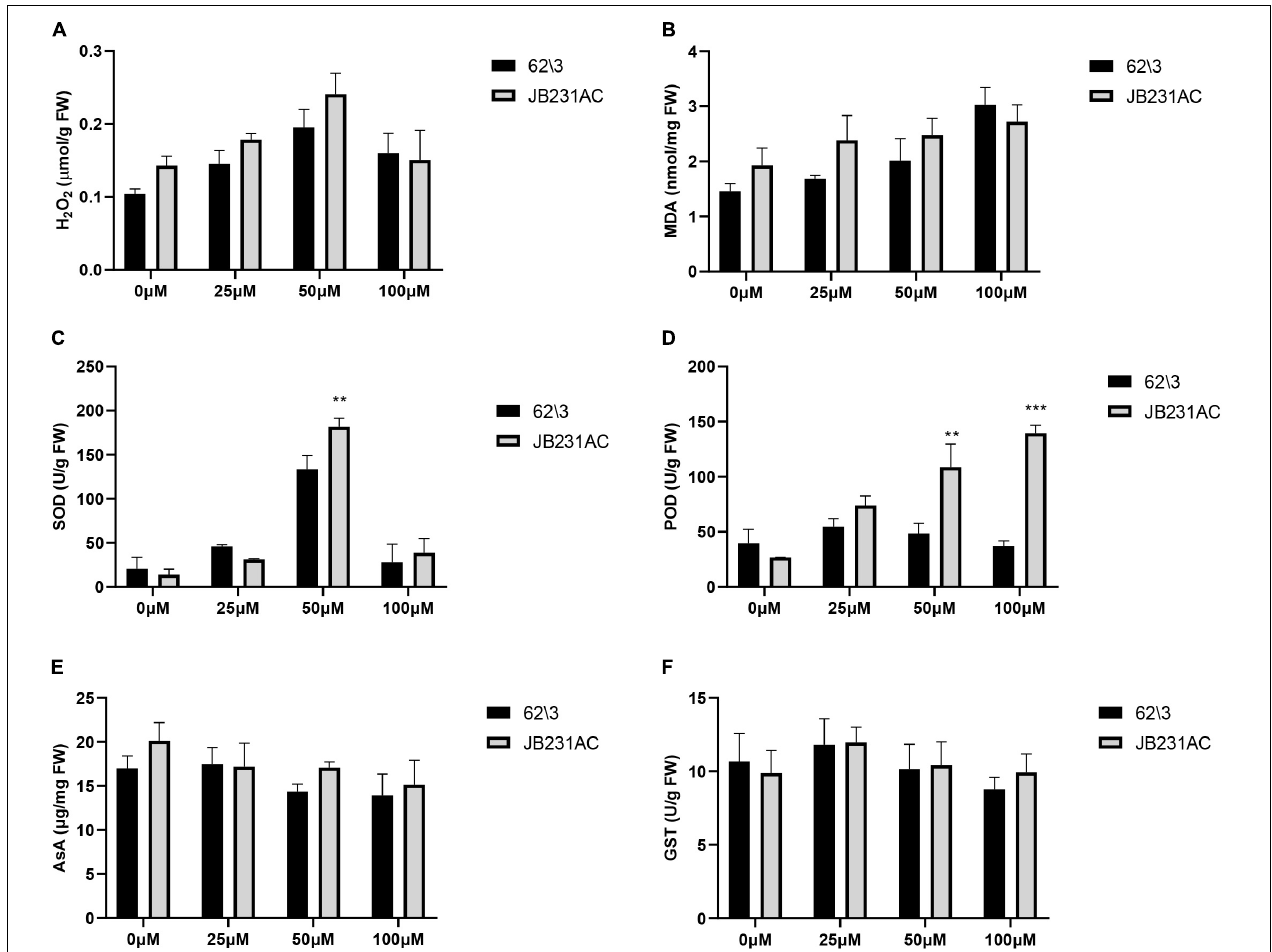
FIGURE 3 | Antioxidant systems of 62\3 and JB231AC under Cd stress. (A) H 2 O 2 content. (B) MDA, Malondialdehyde. (C) SOD, Superoxide dismutase. (D) POD, Peroxidase. (E) AsA, Ascorbic acid. (F) GST, Glutathione S-transferase. For (A–F) the statistical analyses were conducted using all the performance data of 62\3 and JB231AC under Cd stress. Data presented are the means ( n = 3), and error bars denote the standard deviations. The asterisk represent the significant difference between 62\3 and JB231AC under one same Cd stress. **: P < 0.01, ***: P < 0.001.